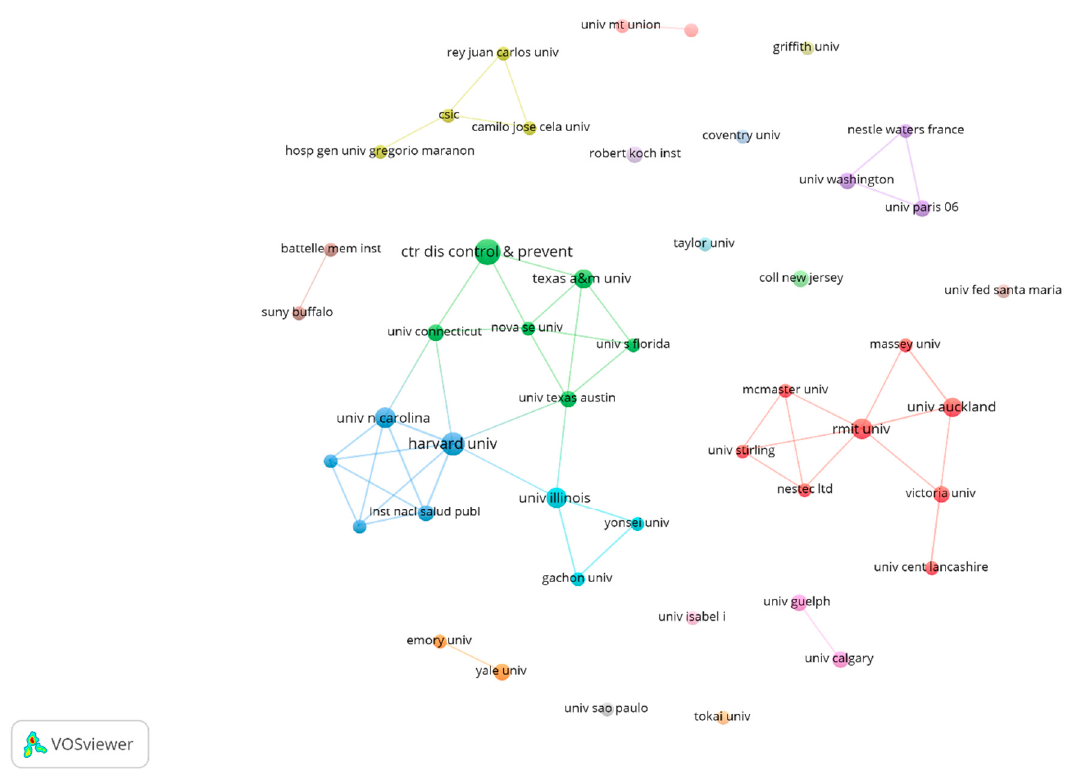
Figure 3. Organizational co-authors graph on coffee/caffeine and sport (only prolific organization authors). Finally, in terms of co-authorship at the country or region level, the USA stands out from the rest of the countries (33 countries) as a hegemony in the production of knowledge on coffee/caffeine and sport with 65 contributions per author affiliation (See Figure 4).